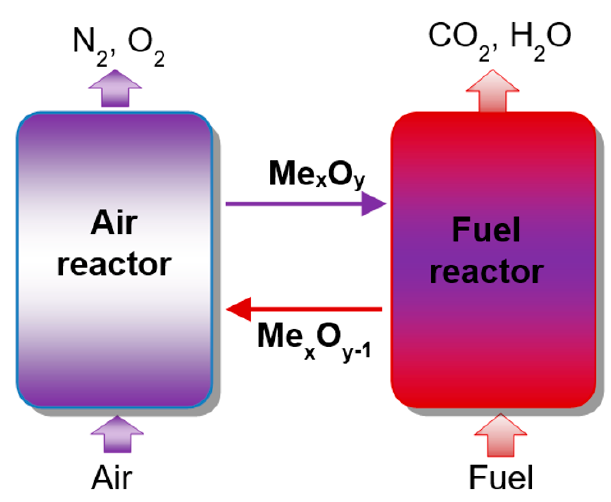
Figure 1. The scheme of the chemical looping combustion (CLC) process.